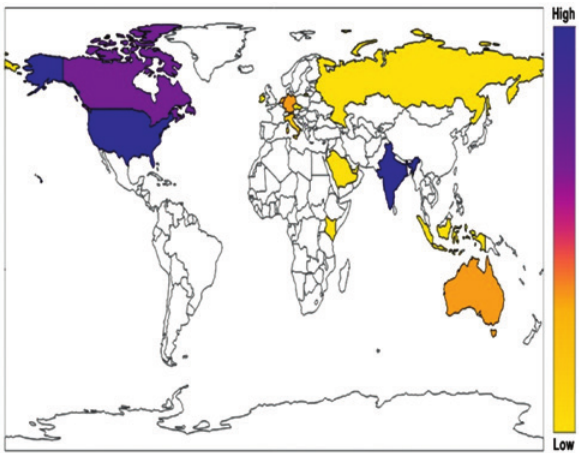
Figure 7: Results of E-motion